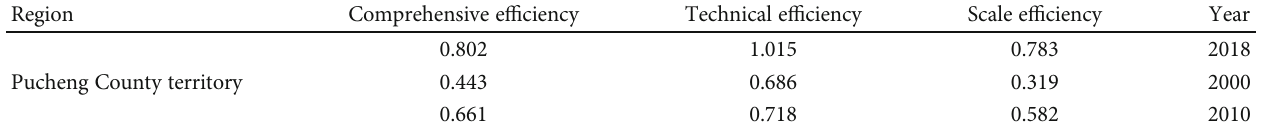
Table 4: Measurement results of spatial performances for 2018, 2000, and 2010.